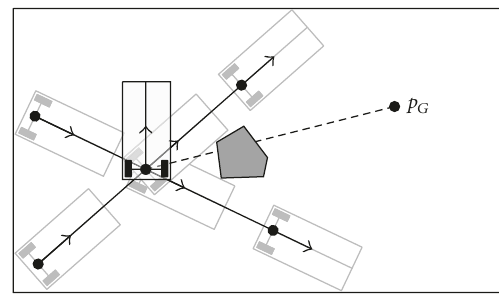
Figure 11: Illustration of the tree extension procedure if the direc- tion to 𝑝 𝐺 is